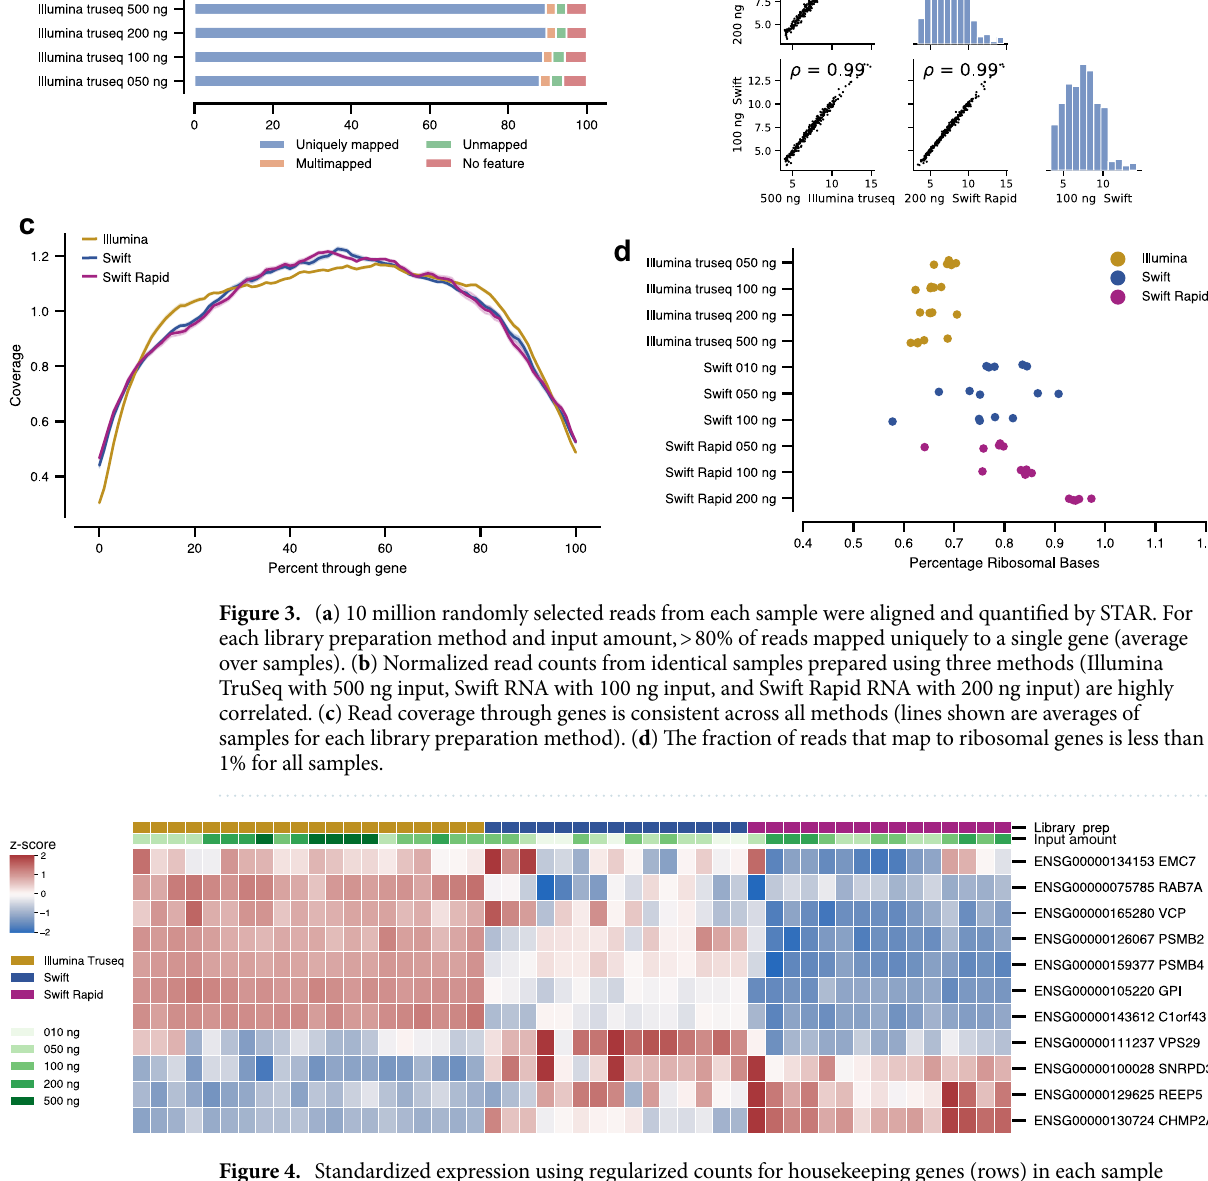
Figure 4. Standardized expression using regularized counts for housekeeping genes (rows) in each sample (columns). Red or blue boxes in the heatmap indicate that a gene’s expression in a sample is above or below the mean over all samples, by the indicated number of standard deviations, respectively. Rows and columns are hierarchically clustered using the Euclidean metric. The differences in gene expression are mostly within a single standard deviation from the